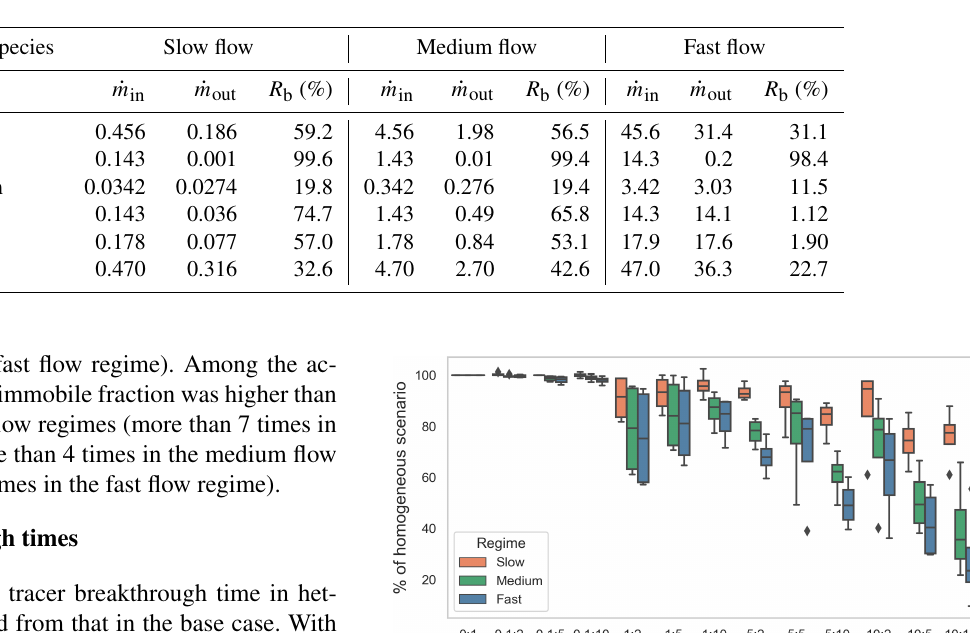
Table 3. Removal of dissolved species ( R b ) in terms of mass flux ( ˙ m in µmold − 1 ) from the homogeneous domain in three flow regimes – slow flow, medium flow, and fast flow.